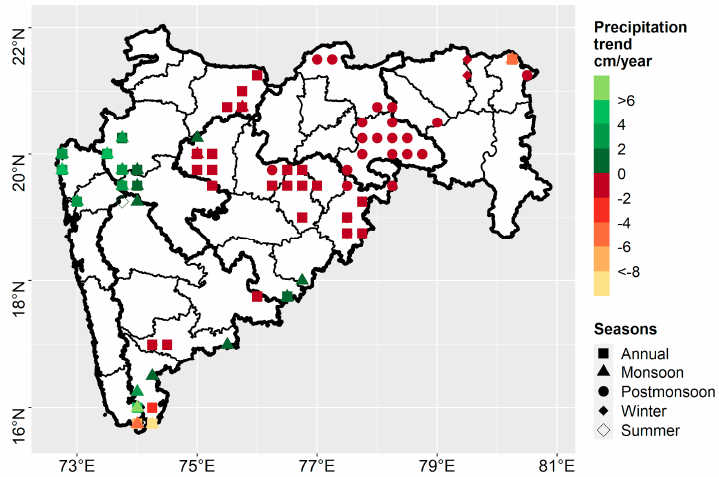
Figure 6. Significant trend ( p < 0.05) in 0.25° × 0.25° gridded precipitation dataset, analyzed